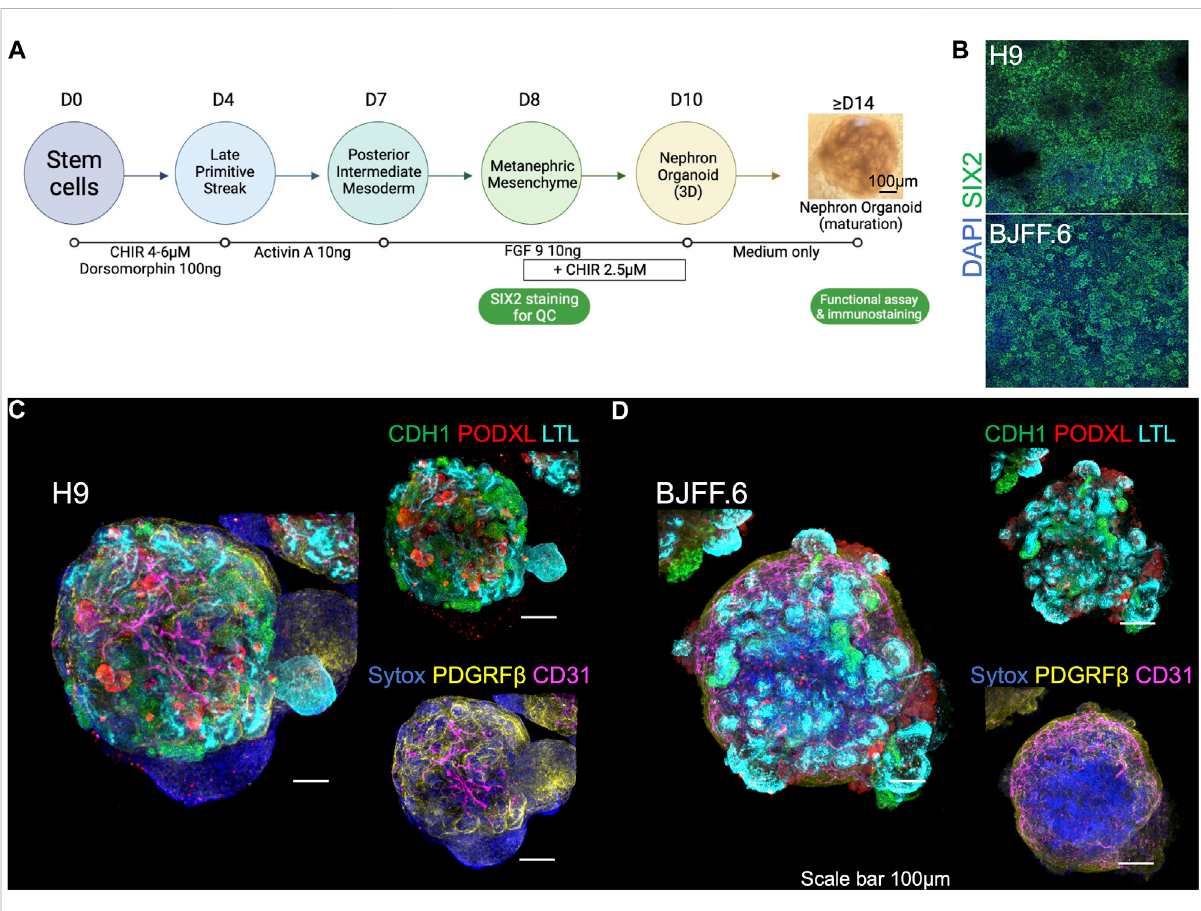
FIGURE 1 Kidney organoids utilized for live imaging functional assay. (A) Steps in generating kidney organoids using the 6-step differentiation protocol (Morizane et al., 2015; Morizane and Bonventre, 2017). Organoids at > d14 are used for live imaging functional assays. (B) SIX2 staining is used to con fi rm the quality of kidney organoid differentiation on embryonic (H9) and induced (BJFF.6) stem cell lines. (C) The d21 kidney organoids derived from both lines form a segmentation of nephrons as presented by CDH1 + , PODXL + , and LTL + cells, as well as containing (D) PDGRF β + stromal and CD31 + endothelial cells. FGF9: fi broblast growth factor 9. LTL, lotus tetragonolobus lectin; PODXL, podocalyxin; CDH1, cadherin-1; PDGFR β , platelet-derived growth factor receptor